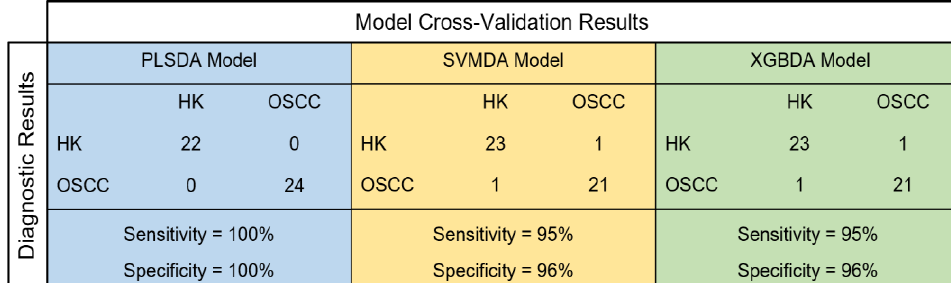
Figure 4. Unsupervised analysis results for all 68 representative spectra in the combined dataset: ( a - 1 ) Reduced Hotelling T 2 versus Q residuals graph of principle component analysis (PCA), and ( a - 2 ) score plot for principal components (PC1 and PC2) of PCA; ( b ) dendrogram graph of hierarchical cluster analysis (HCA).